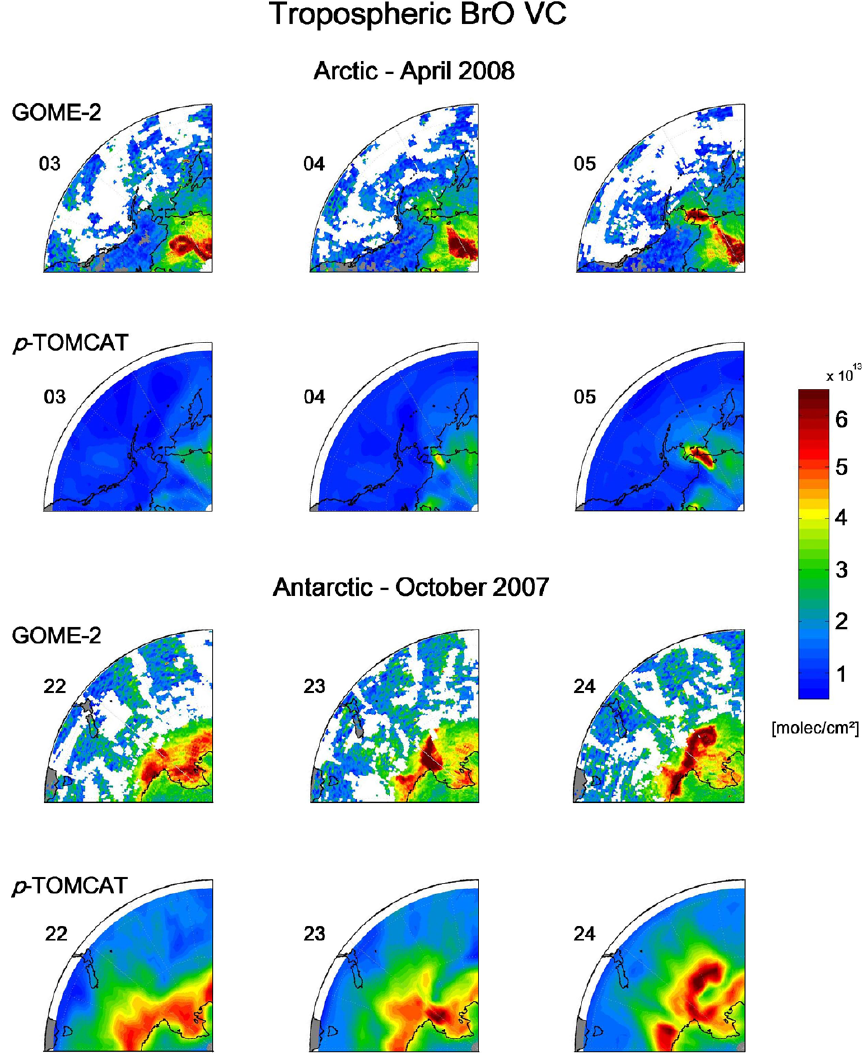
Fig. 13. Tropospheric BrO vertical columns from GOME-2 and p -TOMCAT across the Chukchi Sea region of Arctic from 3 to 5 April 2008 (upper panels) and over the Ross Sea of Antarctica from 22 to 24 October 2007 (lower